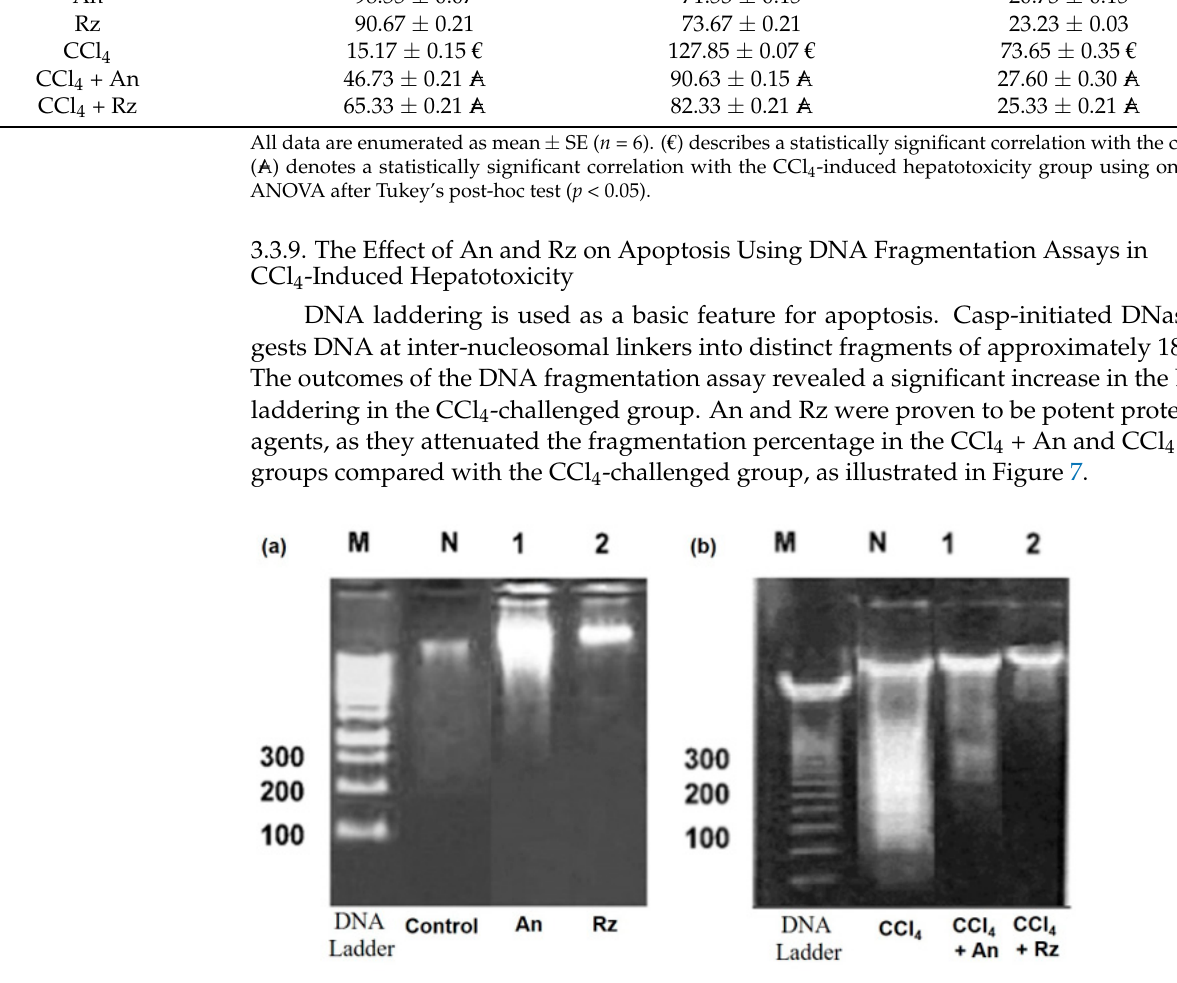
Figure 7. Gel electrophoresis of liver genomic DNA in different animal groups. ( a ) Lane M: DNA ladder, Lane N: normal liver control, Lane 1: An, Lane 2: Rz. ( b ) Lane M: DNA ladder, Lane T: CCl 4